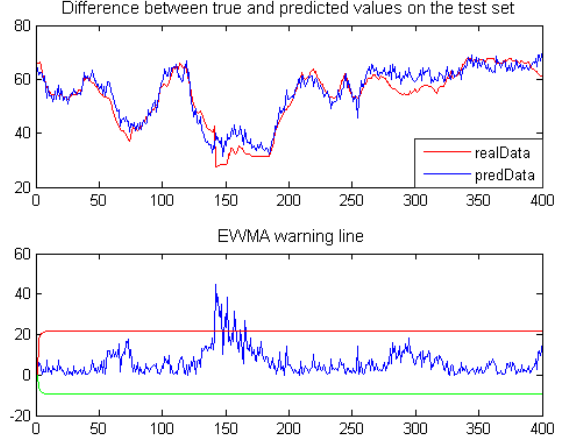
Figure 7. Pitch motor fault early warning.